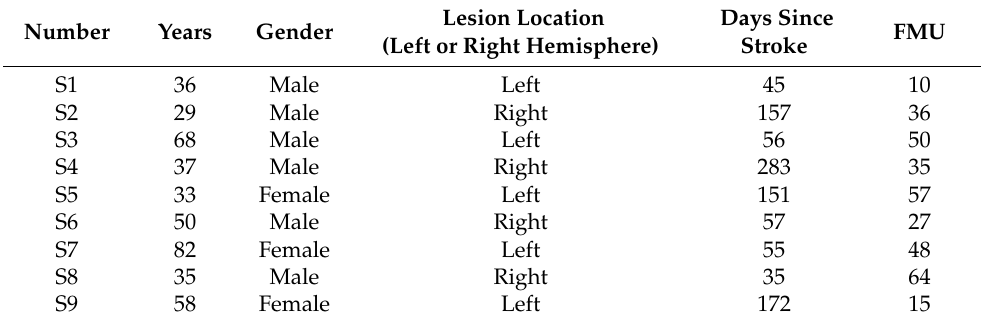
Table 1. The clinical characteristics of stroke patients.